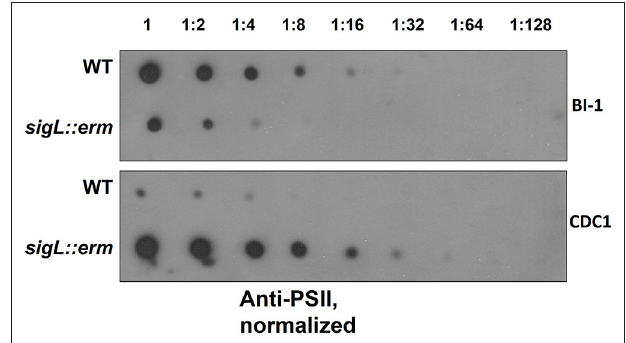
FIGURE 3 | PSII abundance in sigL::erm differs with respect to wild-type strain BI-1 and CDC1. Serially-diluted cell extracts of WT and sigL::erm derivatives (normalized to OD600 = 1.2 in BHI) were spotted on PVDF membranes and immunoblotted using PSII-specific